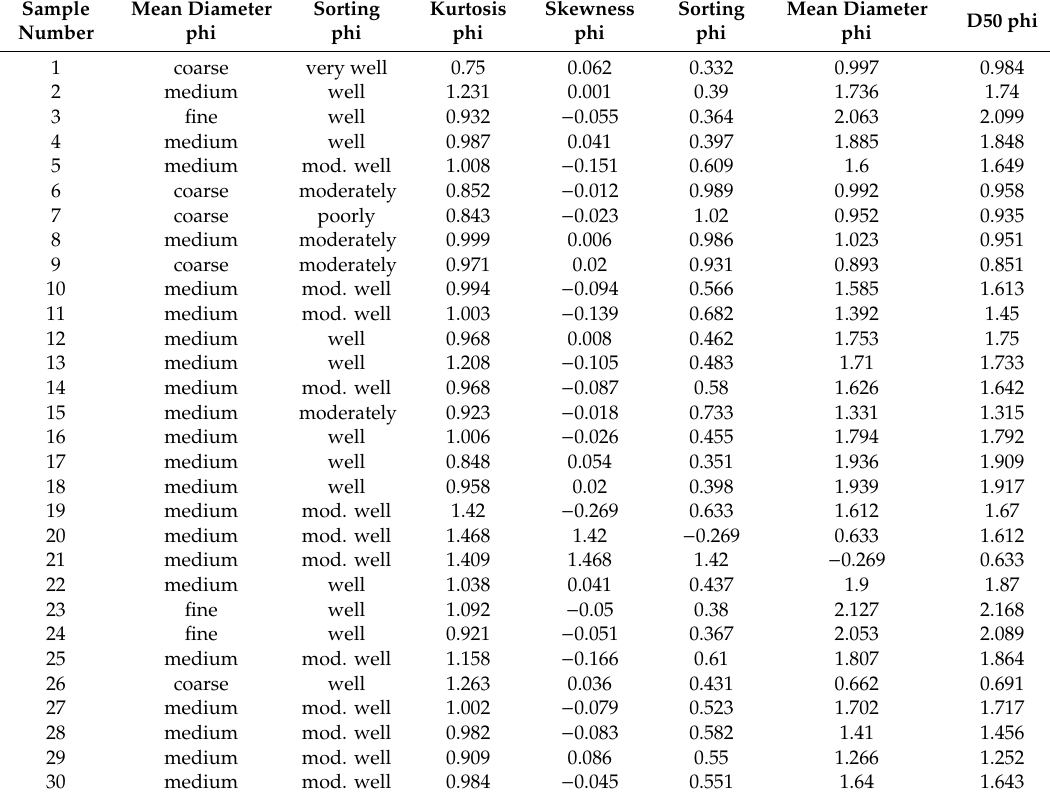
Table 3. Folk and Ward [45] parameters for all sand